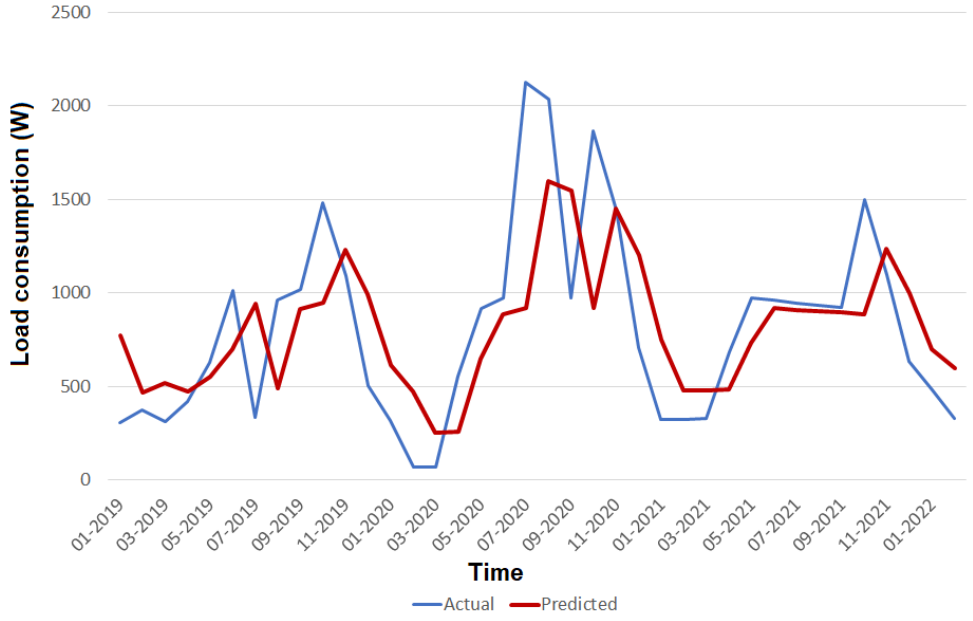
Figure 17. Actual and predicted load consumption values in W versus time for one customer using the ARIMA